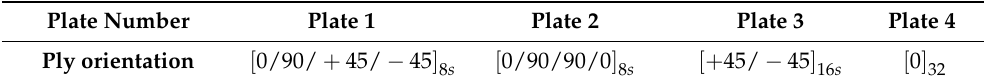
Table 1. Ply configuration of the four plates used in the impact